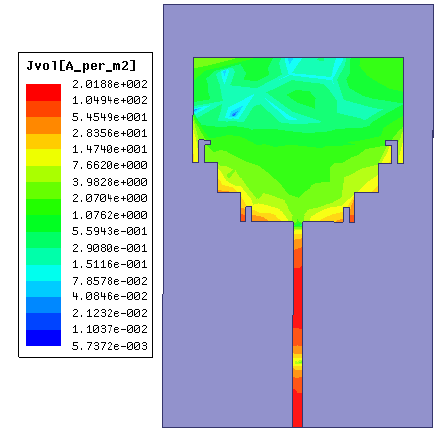
Figure 3. The current distribution of the antenna.